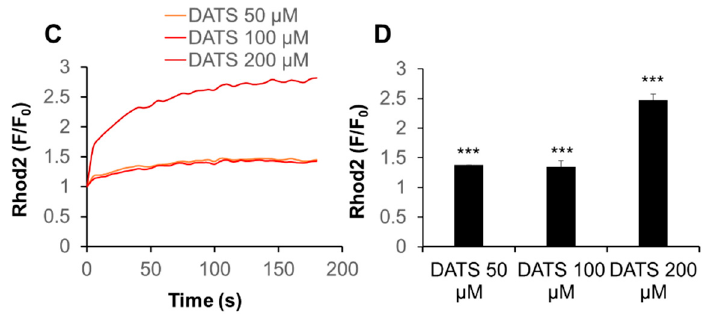
Figure 3. DATS induces Ca 2+mit overload with minimal Ca 2+cyt increase in melanoma cells. ( A , B ) DATS has minimal effect on [Ca 2+ ] cyt . A375 cells were loaded with Fluo4-AM, added with DATS (50, 100, and 200 μ M) or Tg (1 μ M), and immediately measured for fluorescence for 3 min with excitation and emission at 485 and 538 nm, respectively, in a microplate fluorescence reader. [Ca 2+ ] cyt was evaluated as described in Materials and Methods. ( C , D ) DATS induces Ca 2+mit overload in a dose-dependent manner. The cells were loaded with dihydrorhod 2-AM, treated with DATS as described above , and measured for fluorescence with excitation and emission at 542 and 592 nm, respectively. Data are shown as F/F 0 , where F and F 0 represent the fluorescence of the sample and control (medium-treated cells), respectively. Data shown in ( D ) represent the mean ± SE ( n = 3). *** p < 0.001 vs. untreated control.